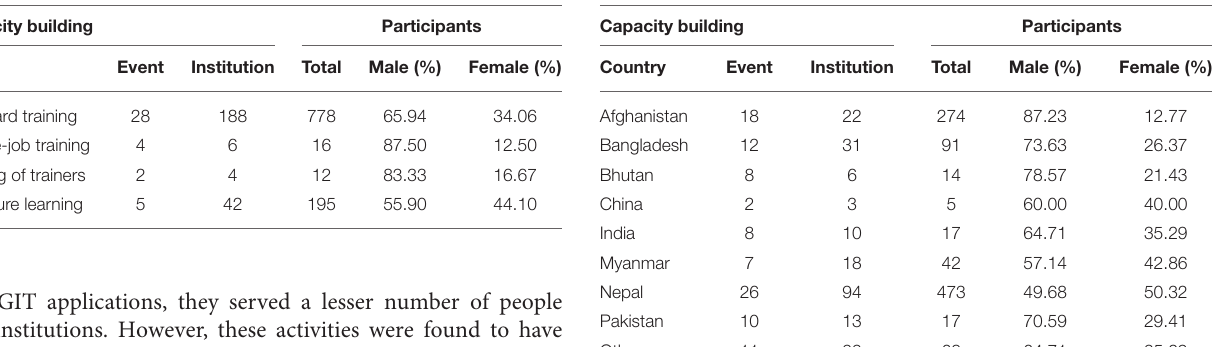
TABLE 6 | Country participation in capacity building events during October 2015–September